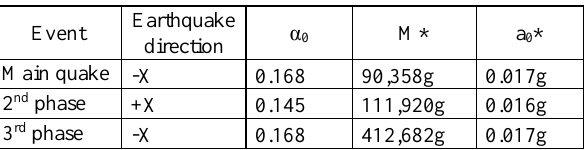
Table 1. Results of the analysis.